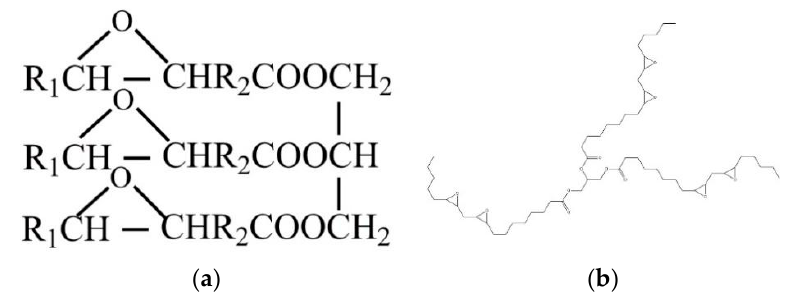
Figure 9. The skeletal structure ( a ) and stereoscopic structure ( b ) of ESO.